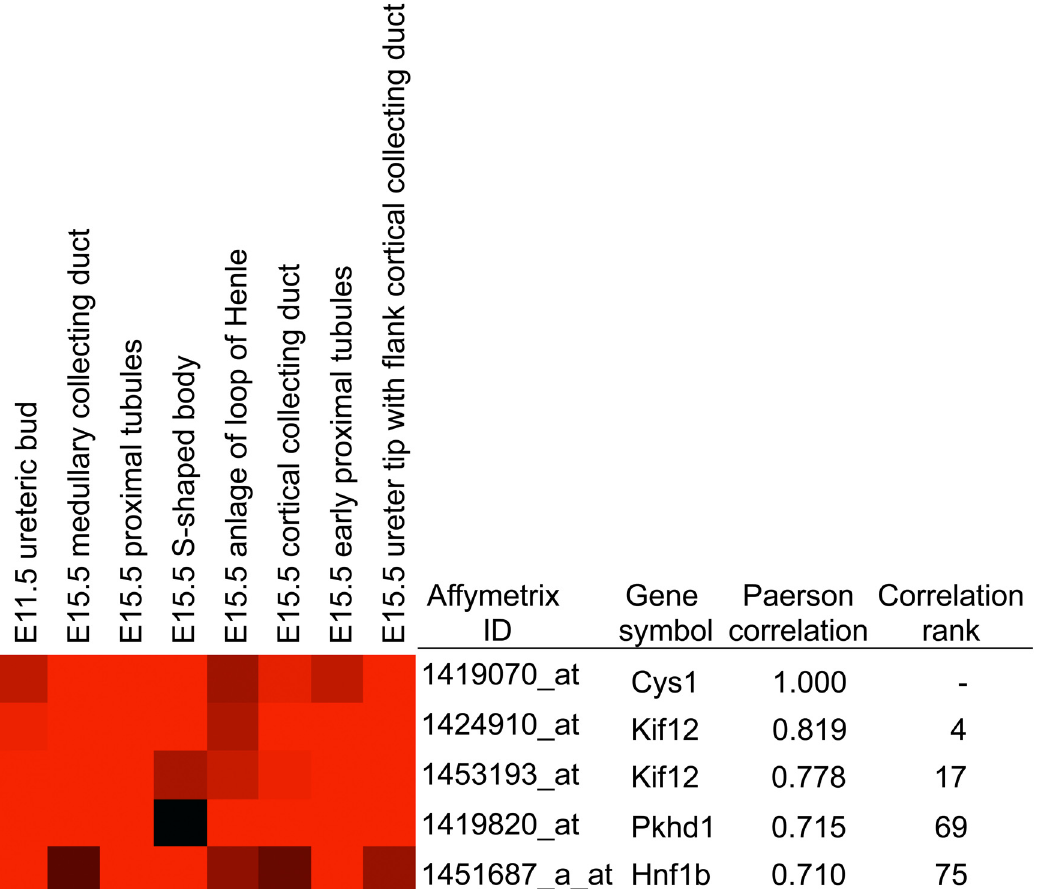
Fig 4. Kif12 expression pattern mimics expression of Cys1 . Among ~40,000 transcripts profiled in 18 different renal anatomical structures at different developmental time-points that were deposited into the GUDMAP Database, Kif12 was the only gene from the Mpkd2 interval whose expression was highly correlated with that of Cys1 . Other non-Chr 4 genes with highly correlated expression patterns included Pkhd1 , the mouse orthologue of the gene mutated in virtually all cases of human ARPKD, and Hnf1b , that encodes a direct transcriptional regulator of Pkhd1 , Cys1 and Kif12 . In addition, Hnf1b mutations result in a renal cystic phenotype (MODY5 syndrome; MIM 137920). The heatmap depicts a subset of structures and developmental stages highly relevant to renal cystic disease. Red shading corresponds to higher expression values; darker shading to lower values.